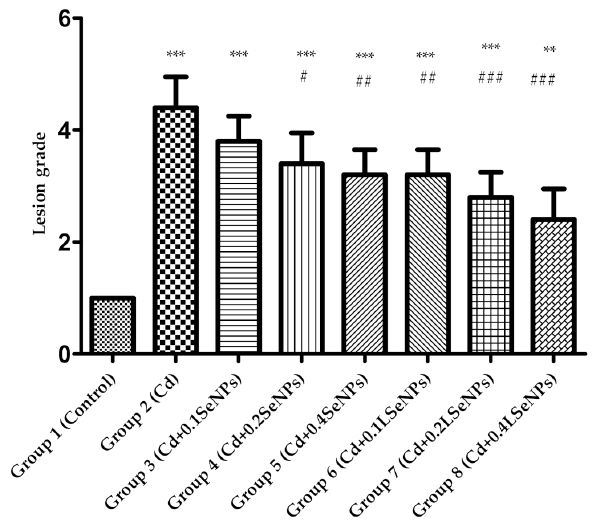
Figure 6. Semi-quantitative assessment of the severity of liver damage ranked from 1 (control status) to 5 (liver damage) induced by cadmium under the protection of SeNPs and LSeNPs. Groups: 1—control; 2—CdCl 2 ; 3—CdCl 2 + 0.1 mg/kg SeNPs; 4—CdCl 2 + 0.2 mg/kg SeNPs; 5—CdCl 2 + 0.4 mg/kg SeNPs; 6—CdCl 2 + 0.1 mg/kg LSeNPs; 7—CdCl 2 + 0.2 mg/kg LSeNPs; 8—CdCl 2